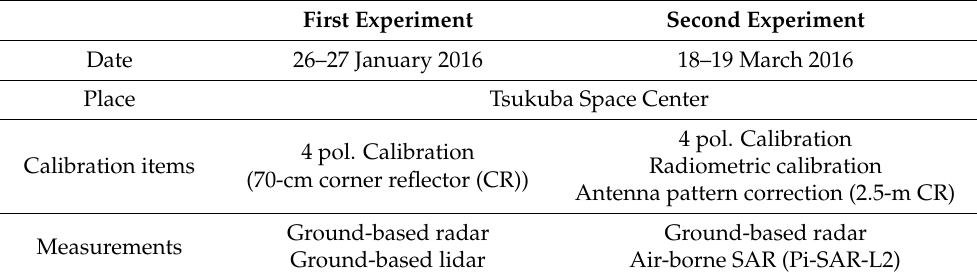
Table 3. Summary of two field